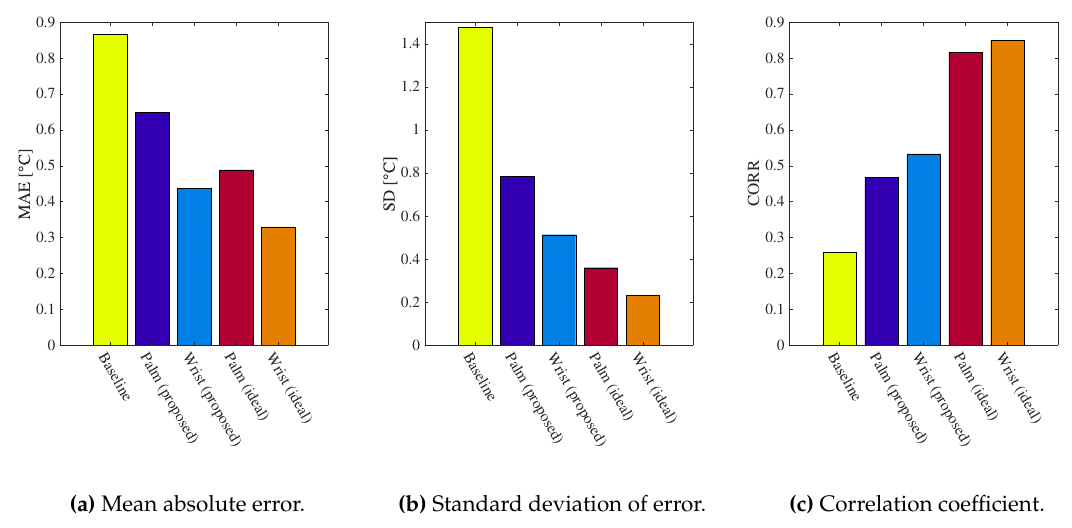
Figure 11. Evaluation in lab